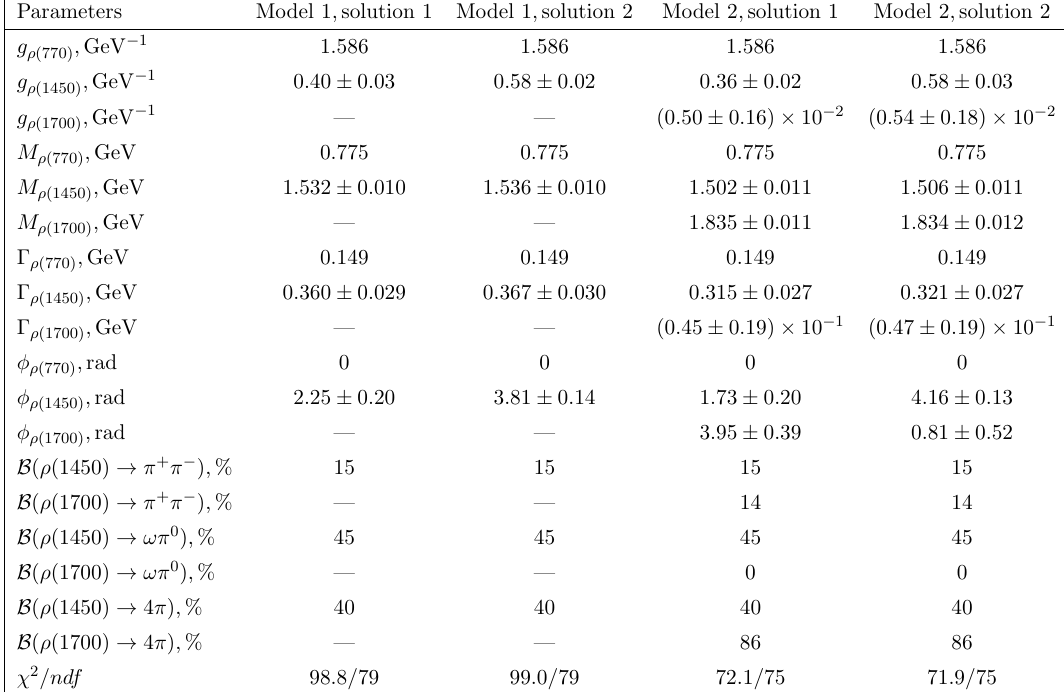
Table 4 . Table of parameters extracted from the (cid:12)t of the e + e (cid:0) ! (cid:17)(cid:25) + (cid:25) (cid:0) cross section in the VMD model. Parameters listed without uncertainties are (cid:12)xed. All listed uncertainties are statistical.